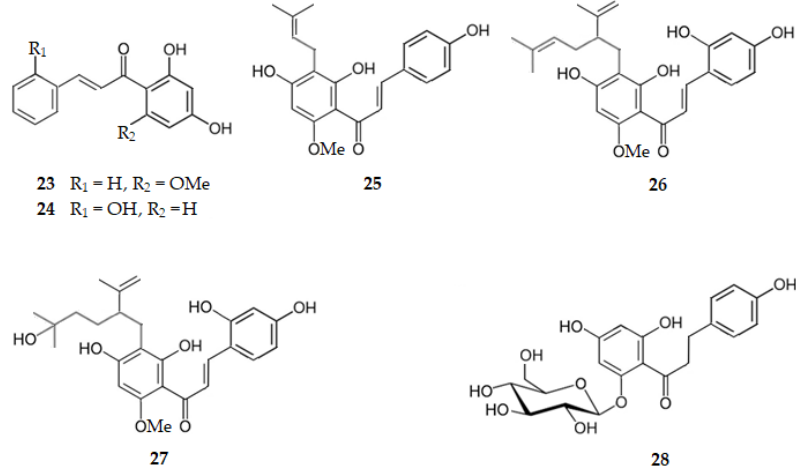
Figure 6. Structure of chalcones and dihydrochalcones that inhibit β -secretase.